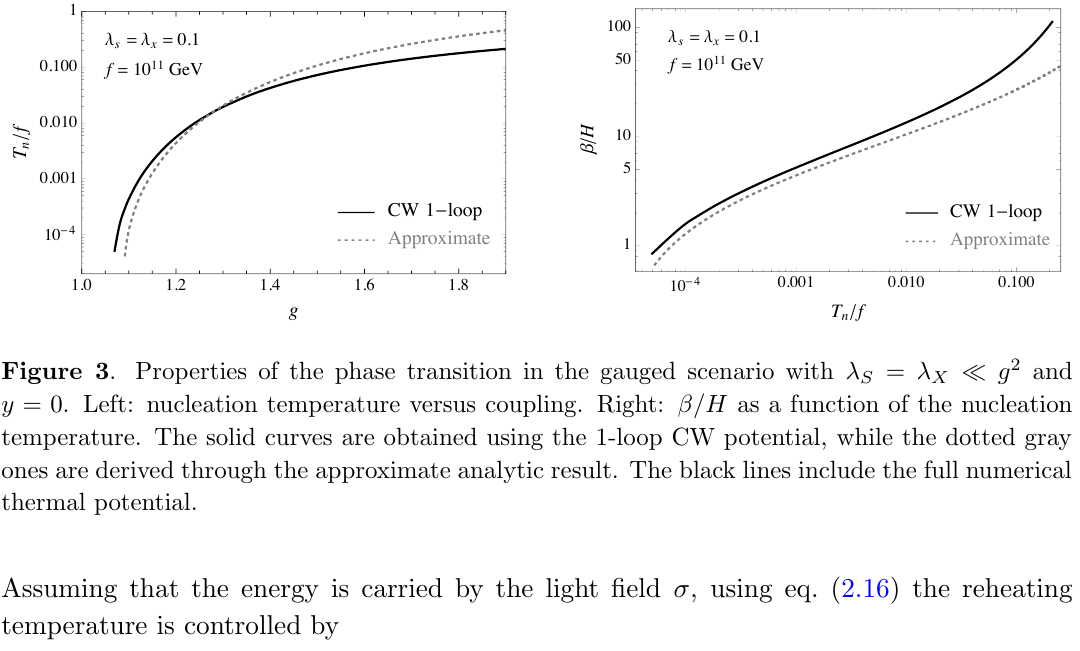
Figure 2 . Properties of the phase transition in the scenario with g = 0, y = 0 and (cid:21) S = (cid:21) X . Left: nucleation temperature versus coupling. Right: (cid:12)=H as a function of the nucleation temperature. The solid curves correspond to the results using the improved 1-loop potential. The dot-dashed lines are instead obtained from the usual 1-loop CW potential without improvement. Finally the dotted gray curves are derived through the analytical approximation in eq. (2.30). The black lines include the full numerical thermal potential.